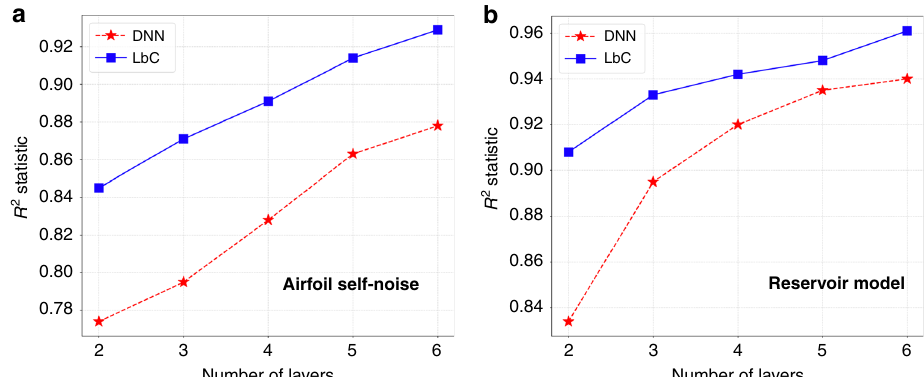
Fig. 2 Impact of loss-function choice on model complexity. Comparing the performance of emulators designed using conventional deep neural networks (DNN) with MSE as the optimization objective and the proposed approach that utilizes a calibration objective: a airfoil self-noise dataset, b reservoir model dataset. We fi nd that regardless of the complexity of the model (varying depth), the proposed approach produces improved emulators. Though Learn-by- Calibrating (LbC) uses an additional network for estimating the intervals during training, at inference time, the predictions are obtained using only the network f whose number of parameters are exactly the same as that of the DNN baseline.